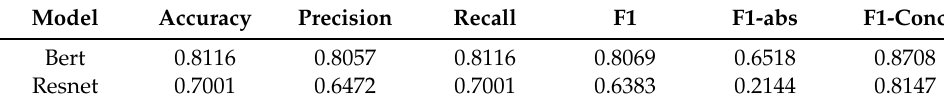
Table 4. Experimental results of the multi-modal pre-training